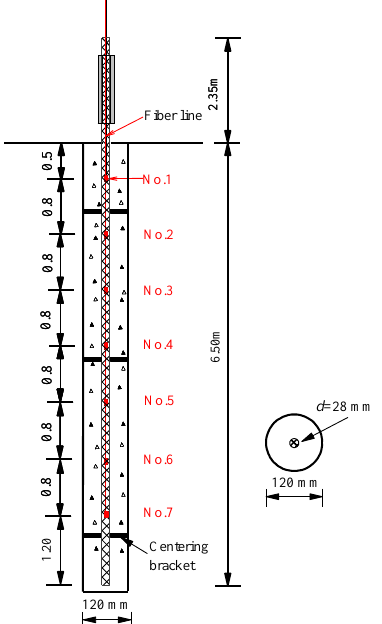
Figure 2. Schematic diagram of instrumented glass fiber-reinforced polymer (GFRP) anchor.